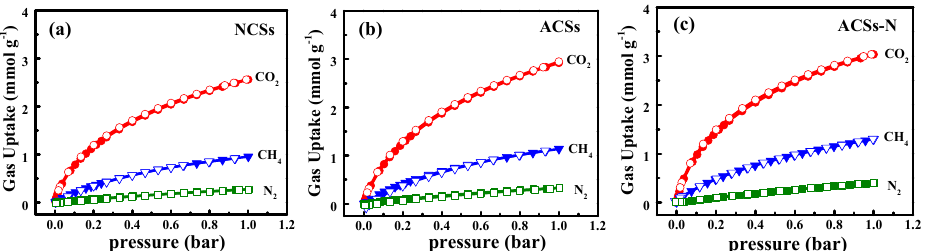
Figure 6. Adsorption (solid) and desorption (open) isotherms of CO 2 , CH 4 , and N 2 on ( a ) NCSs, ( b ) ACSs, and ( c ) ACSs-N at 25 °C.